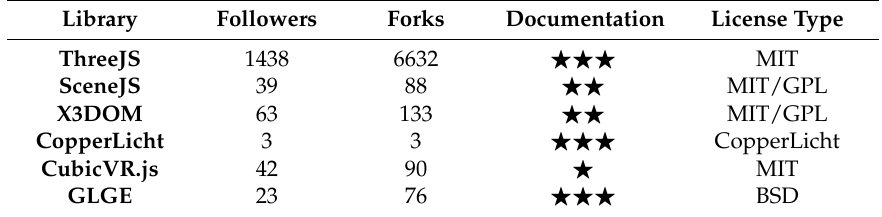
Table 2. Exploratory research summary of HTML5/WebGL high level libraries (February